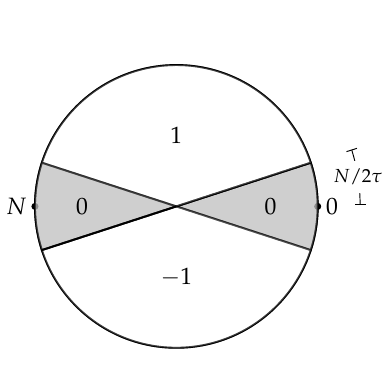
Figure 2. Illustration of the slices for the test vector coefficients of sign bootstrapping (when τ =